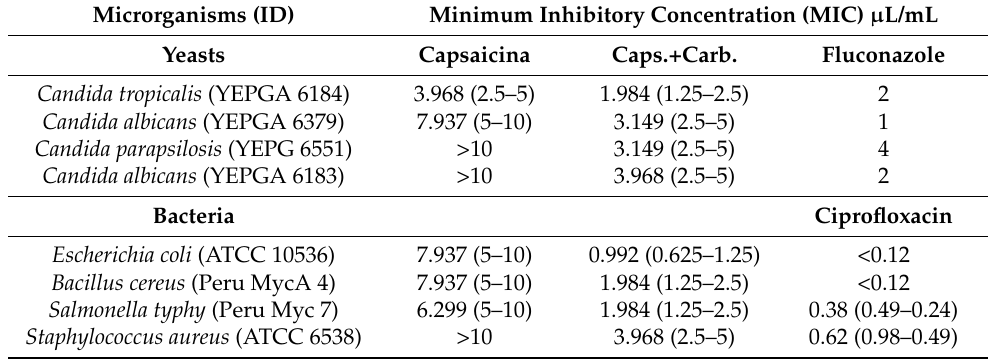
Table 2. Minimum inhibitory concentration of Capsaicin and Carbopol